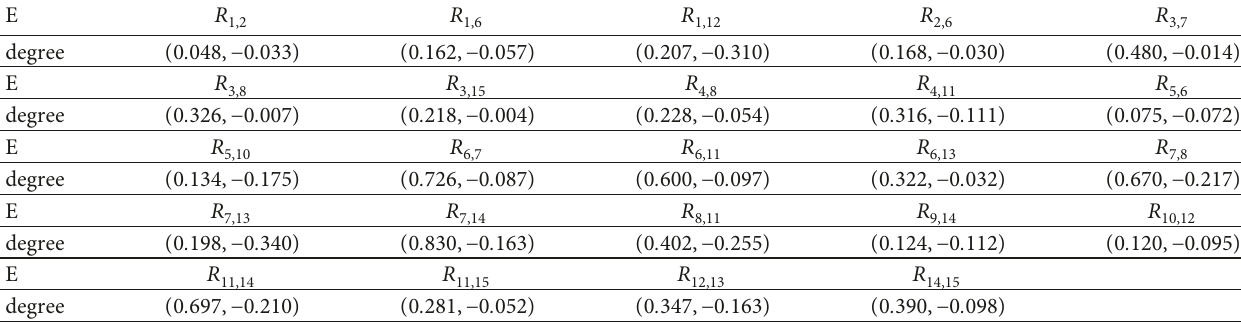
Table 5: Bipolar-valued fuzzy membership degrees of coauthor relations.